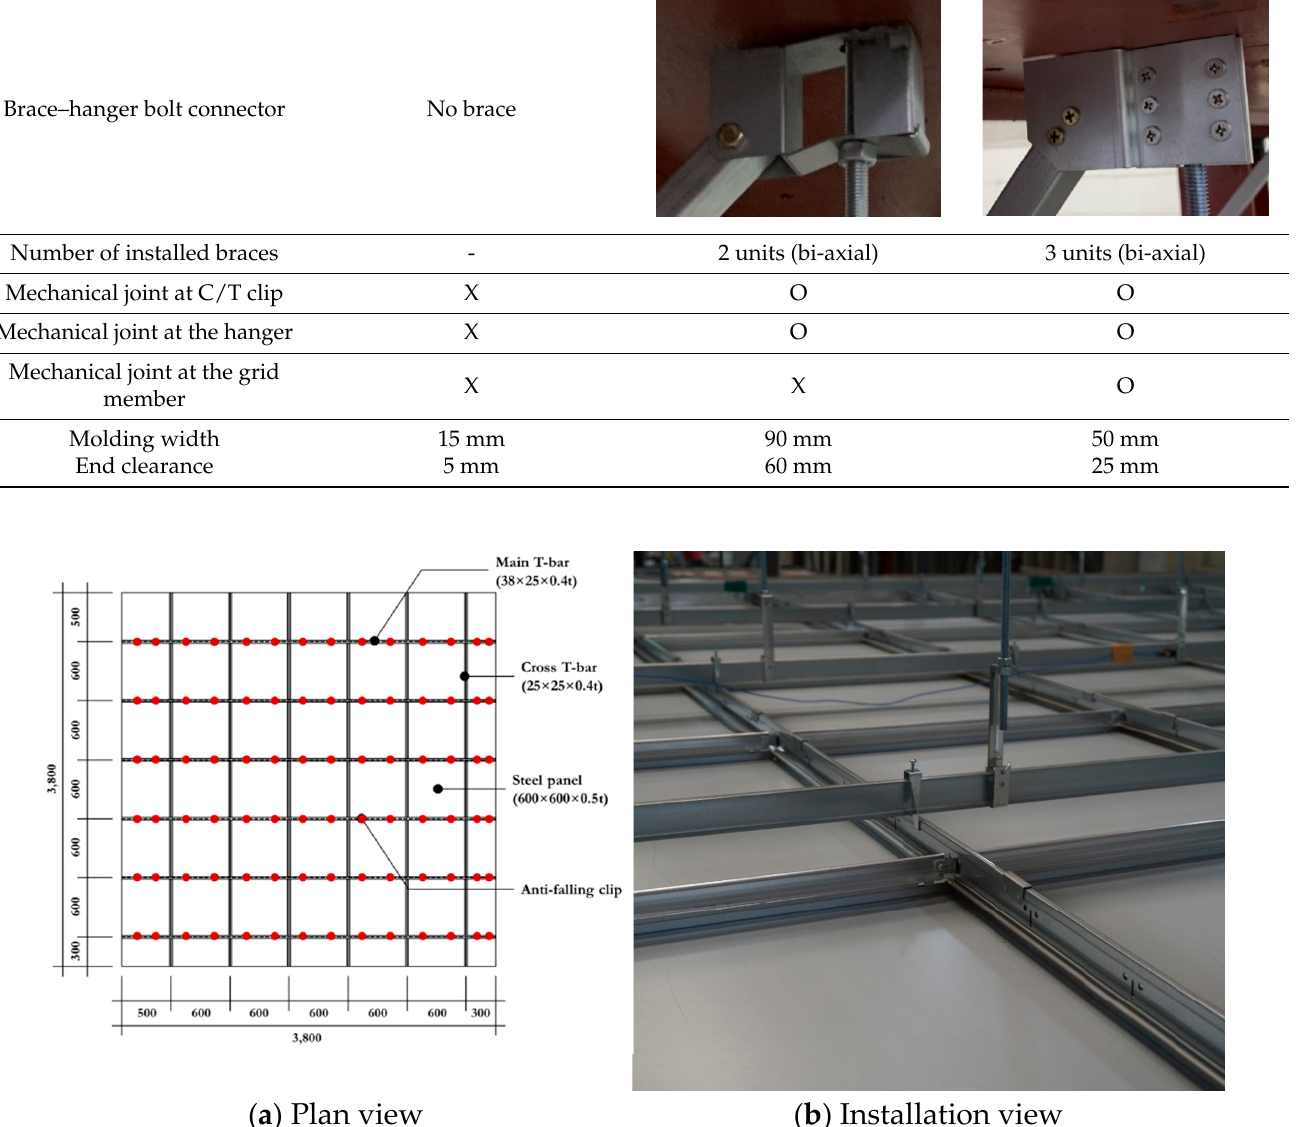
Figure 5. Main T-bar and the cross T-bar plan: ( a ) plan view of the specimen (main T-bar–cross T- bar), and the ( b ) installation view of the specimen.